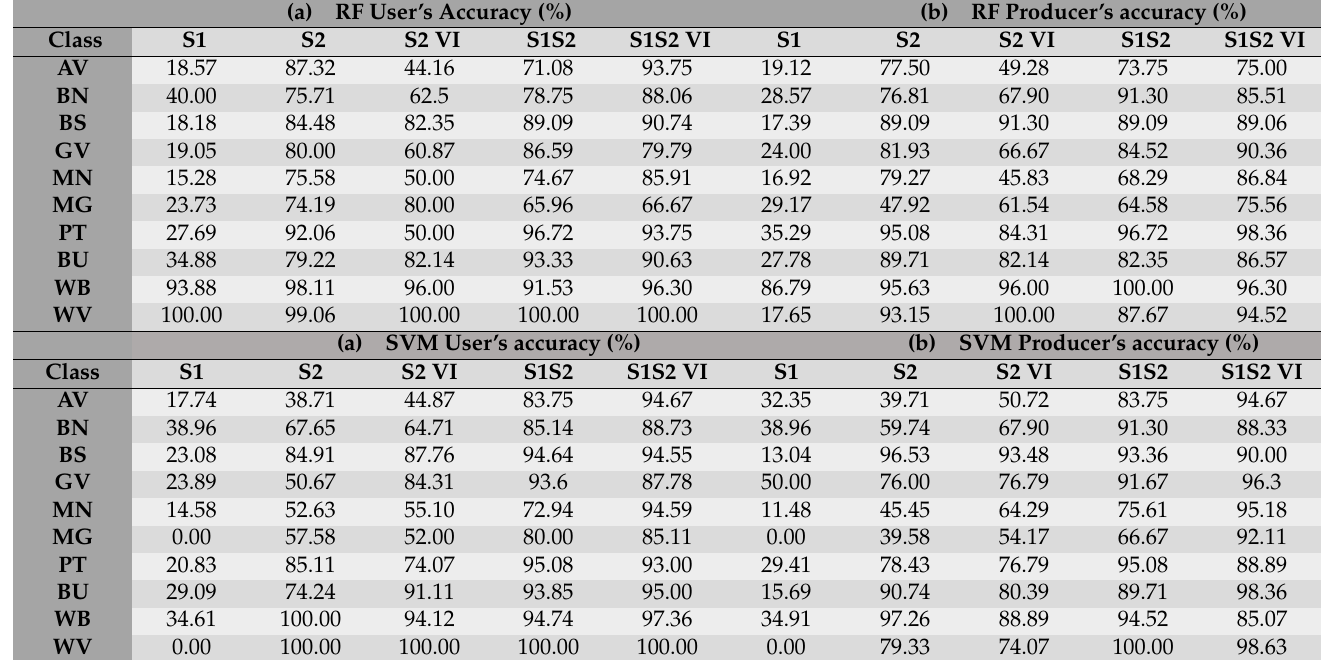
Table 3. The performance of RF and SVM over four datasets (S1, S2, S2 selected variables, S1S2,